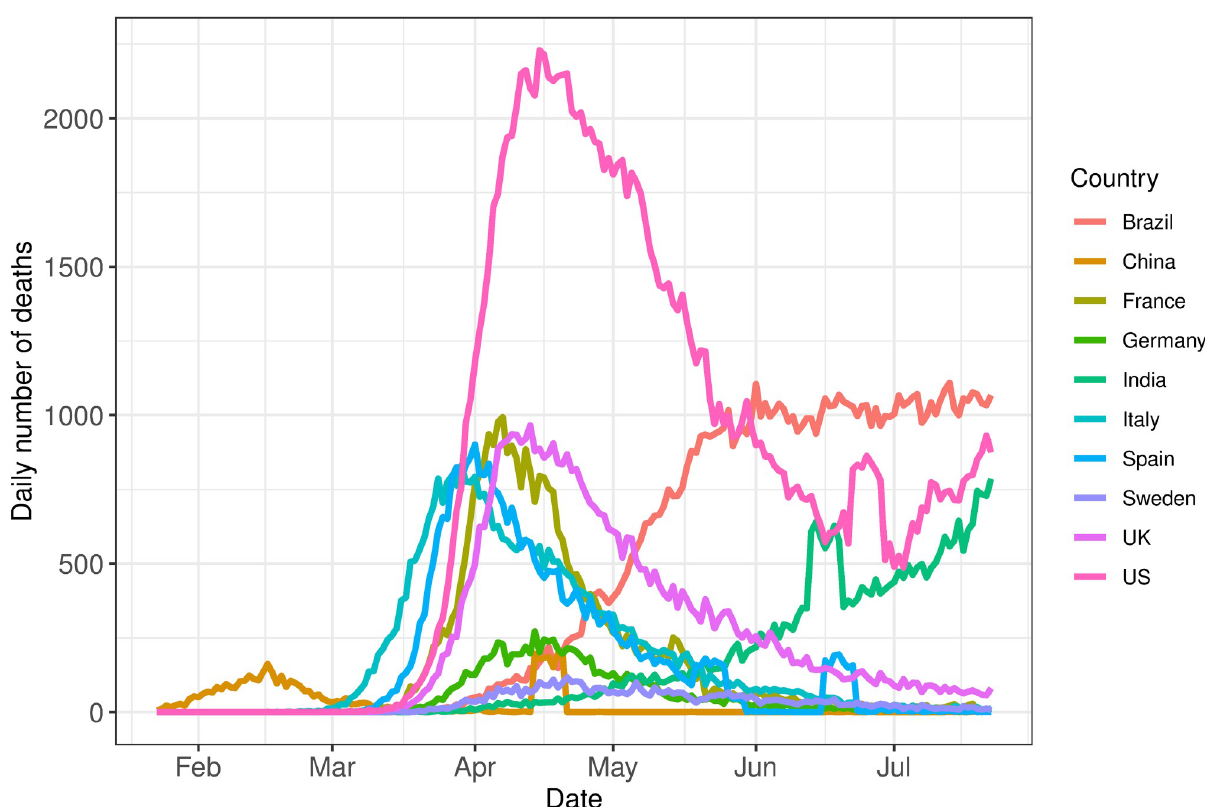
Fig 1. Observed data. Daily volume of deaths due to COVID-19 for the countries selected in this analysis.